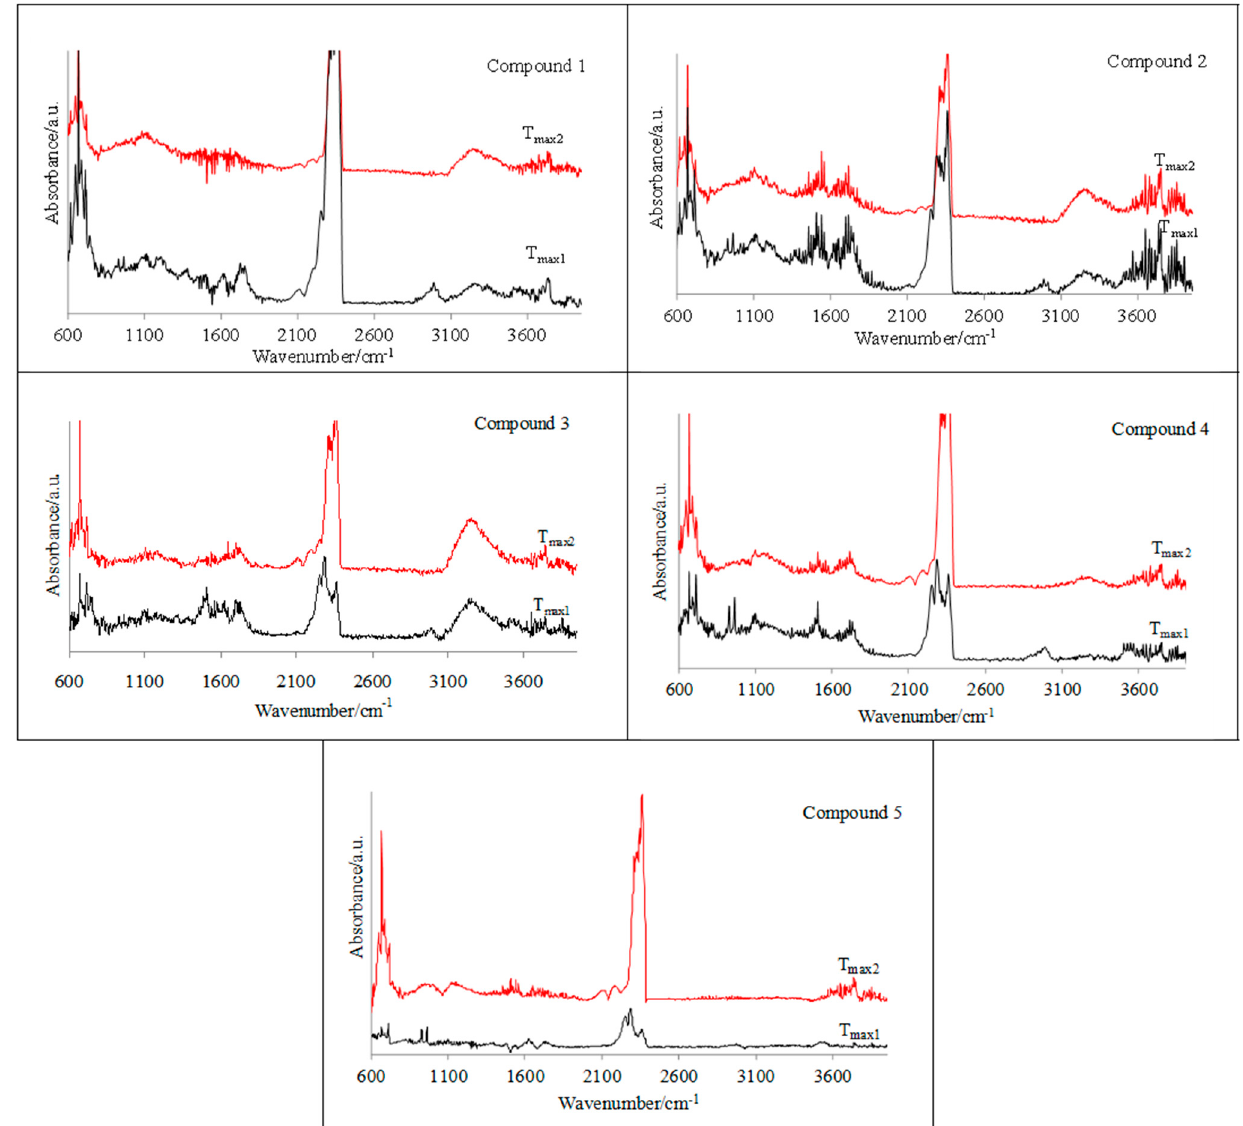
Figure 8. The gaseous FTIR spectra of volatiles emitted under the heating of the tested compounds in an oxidizing atmosphere.